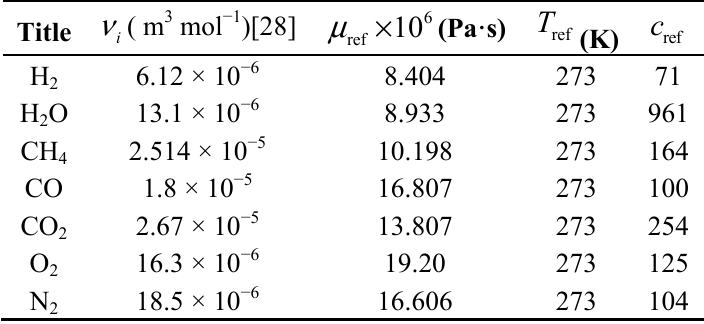
Table 5. Diffusion volume and coefficients of viscosity coefficient.